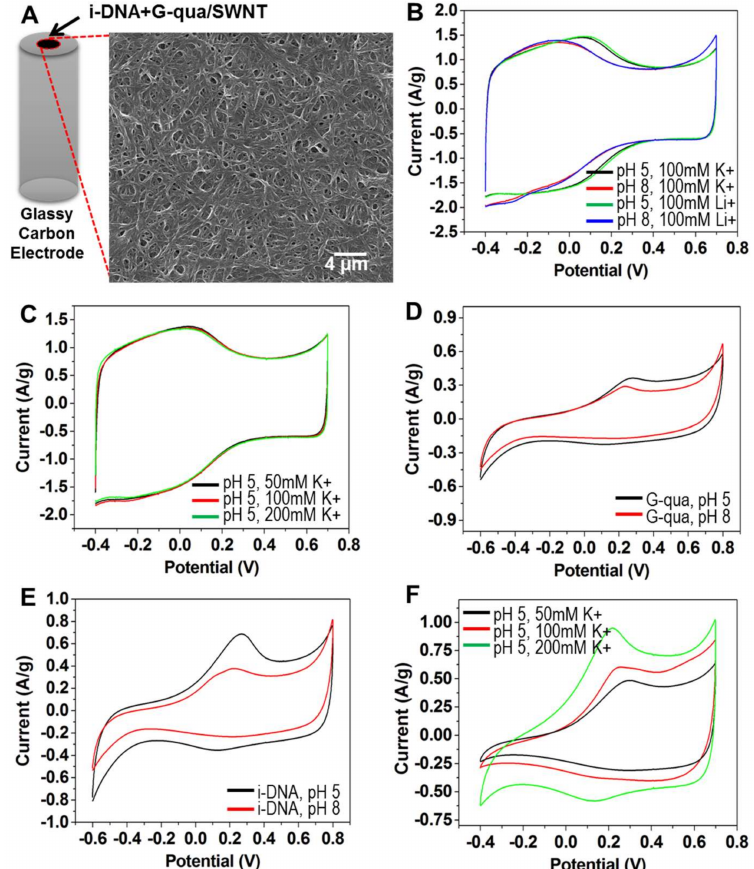
Figure 4. ( A ) Scanning Electron Microscopy (SEM) image of i-DNA/f-SWNT and G-quadruplex/ f-SWNT mixture showing fibrous nanostructures, and cyclic voltammetry (CV) curves of ( B ) pristine f-SWNT at pH 5 (black and green) and 8 (red and blue) with 100 mM K + and Li + ions; ( C ) pristine f-SWNT in pH 5 with presence of 50 mM (black), 100 mM (red), and 200 mM (green) K + ; ( D ) G-quadruplex/f-SWNT in PBS at pH 5 (black) and 8 (red); ( E ) i-DNA/f-SWNT in PBS at pH 5 (black) and 8 (red); and ( F ) mixture of i-DNA/f-SWNT and G-quadruplex/f-SWNT in pH 5 with 50 mM (black), 100 mM (red), and 200 mM (green) K +